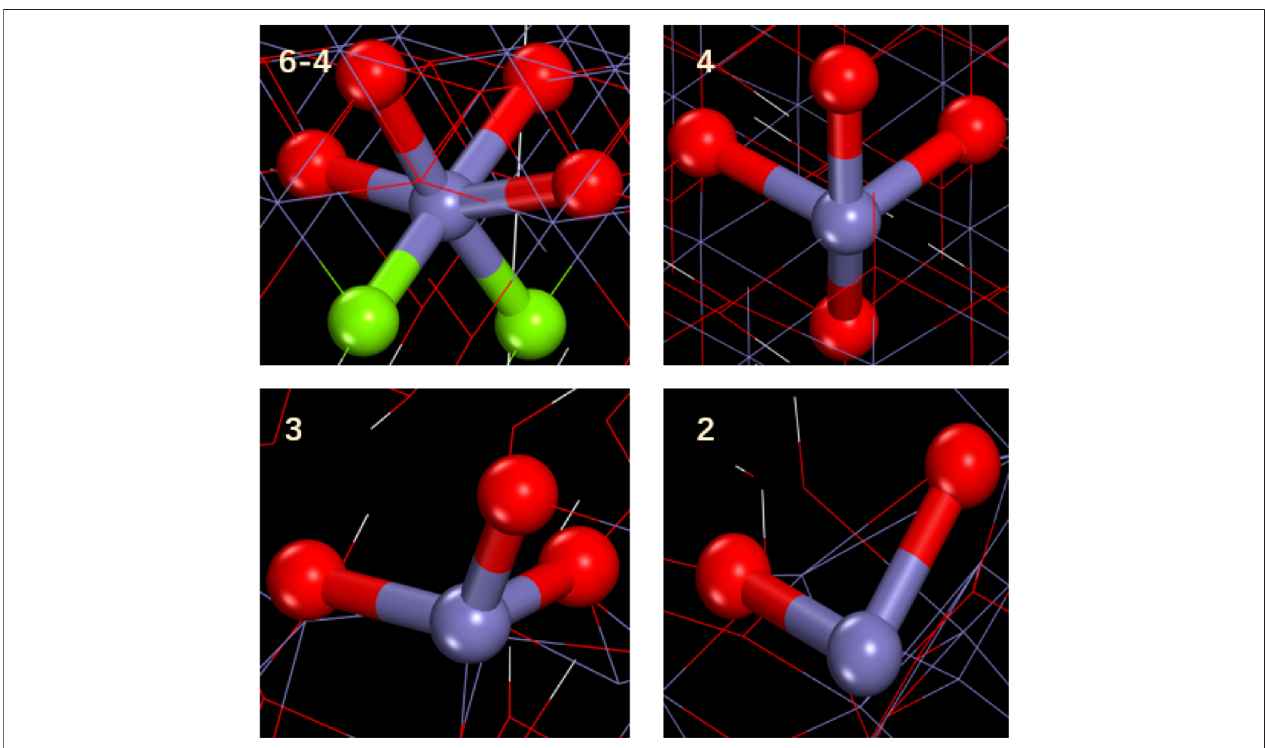
FIGURE 13 | Partial structure of Fe with different coordination in γ -FeOOH. Green balls represent oxygen on the hydroxyl group, and red balls represent oxygen atoms connecting two iron atoms.